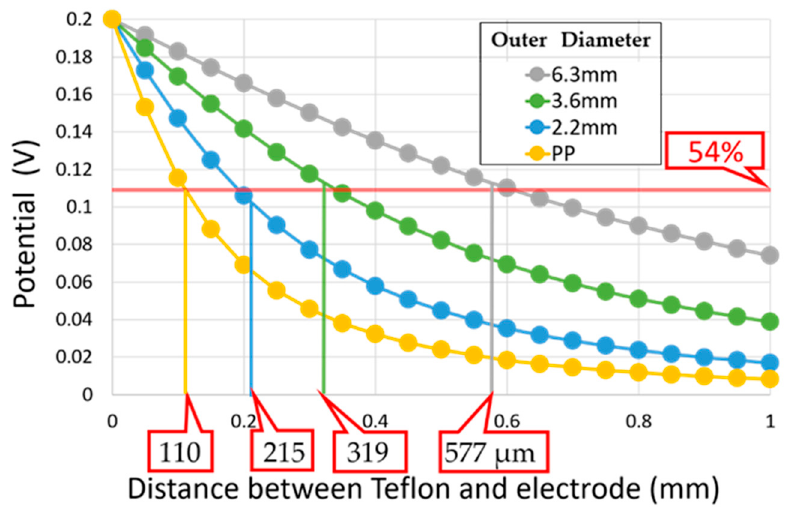
Figure 5. Penetration depth determined from potential obtained by the finite element method (FEM) for each electrode .